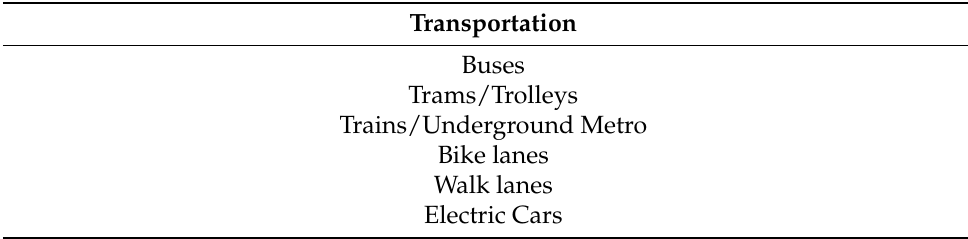
Table 9. Available transportation